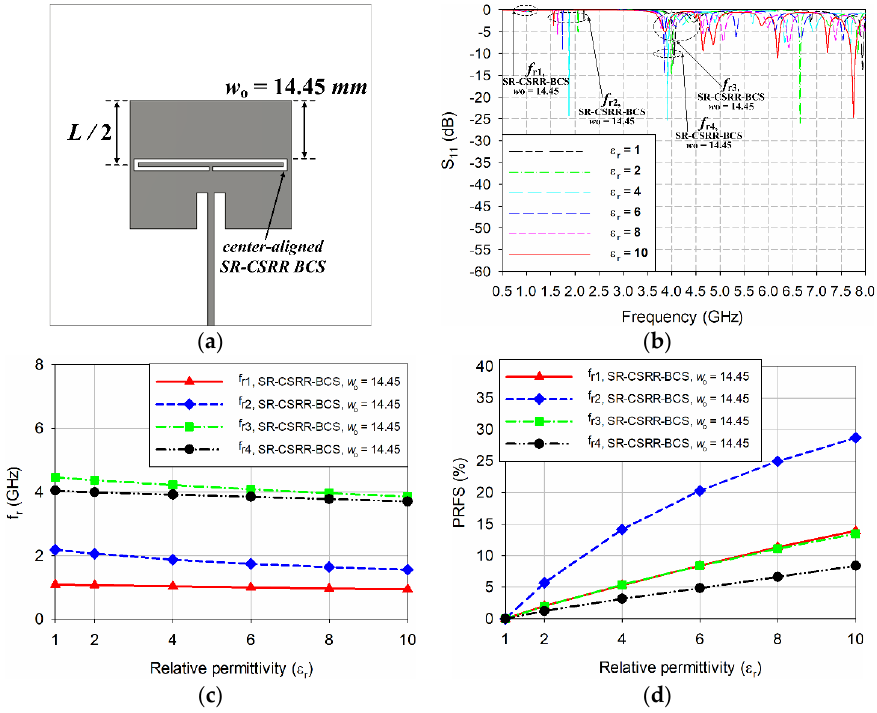
Figure 9. Characteristics of the center ‐ aligned SR ‐ CSRR ‐ BCS slot ‐ loaded MPA ( w o = 14.45 mm): ( a ) antenna geometry, ( b ) input reflection coefficient characteristic, ( c ) values of the first four resonant frequencies, and ( d ) PRFS of the first four resonant frequencies.